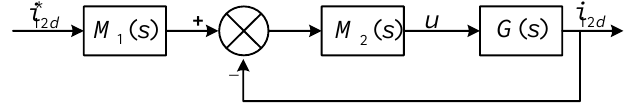
From Equation (18), the block diagram of the first-order LADRC transfer function as shown in Figure 3 can be derived, where G ( s ) represents the plant.